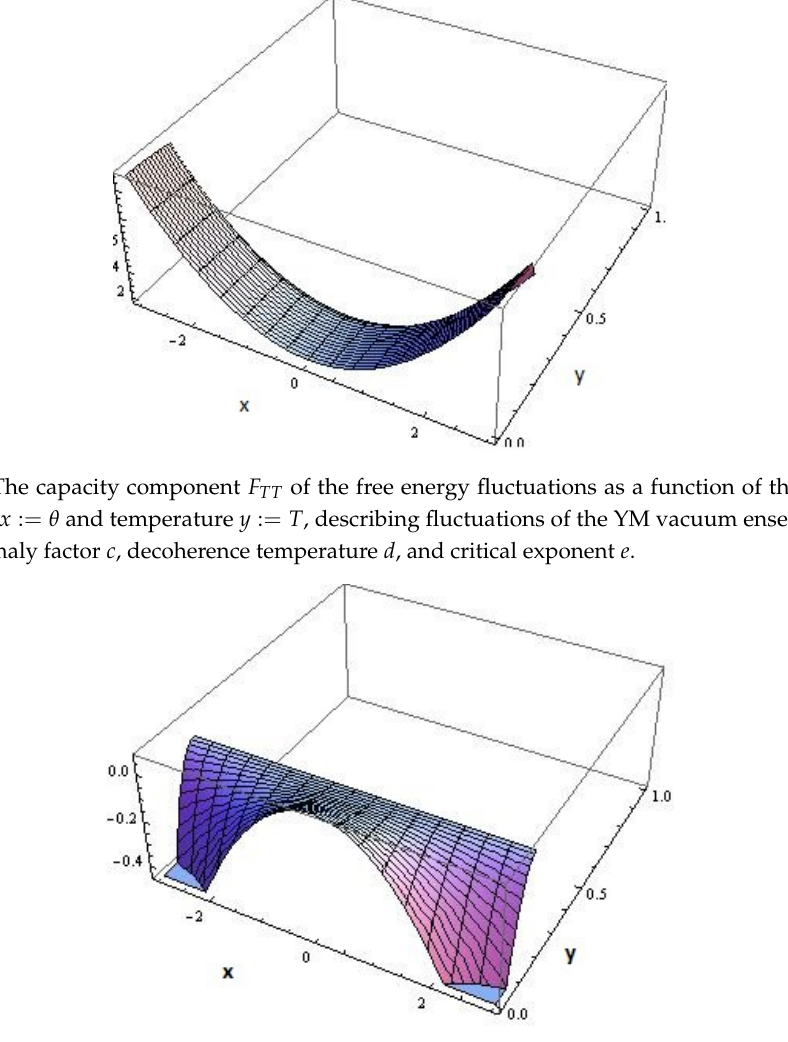
Figure 7. The determinant (cid:107) g (cid:107) of the metric tensor g defined as the Hessian of the free energy as a function of the vacuum parameter x : = θ and temperature y : = T , describing fluctuations of the YM vacuum ensemble for a given anomaly factor c , decoherence temperature d , and critical exponent e